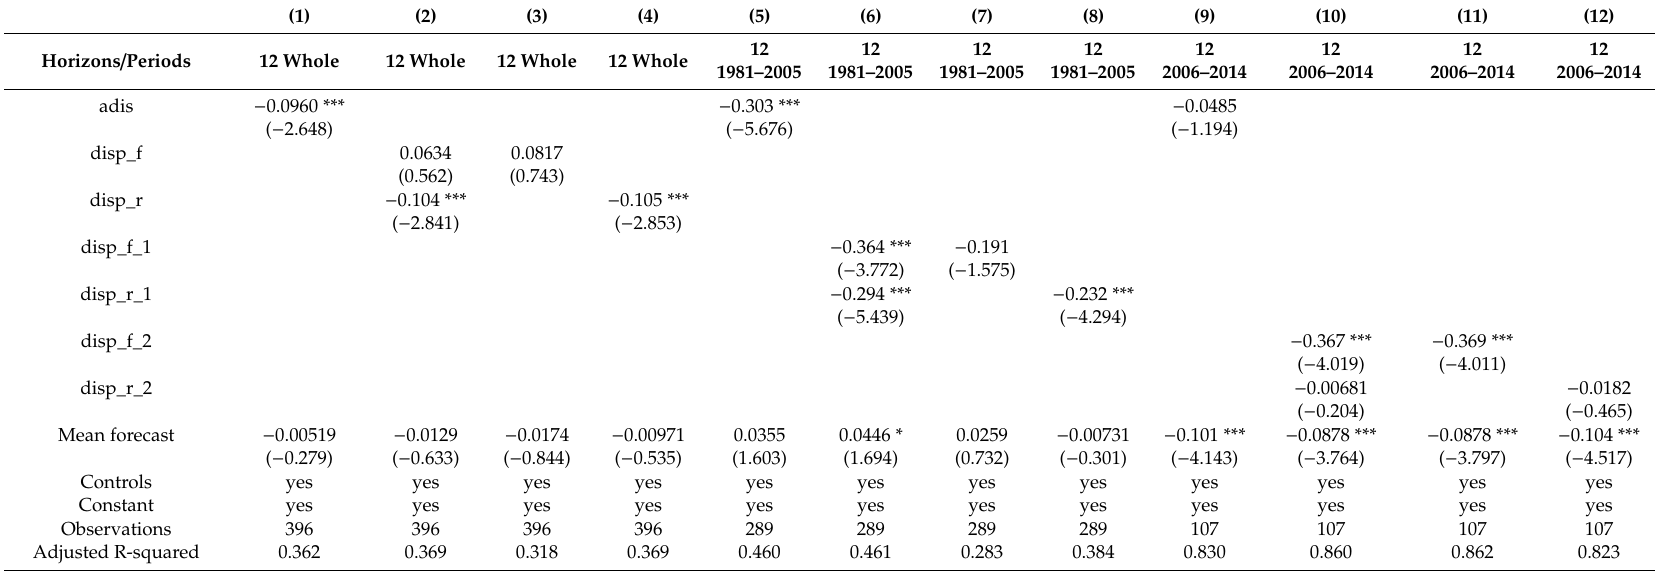
Table 5. Return on dispersion and its two